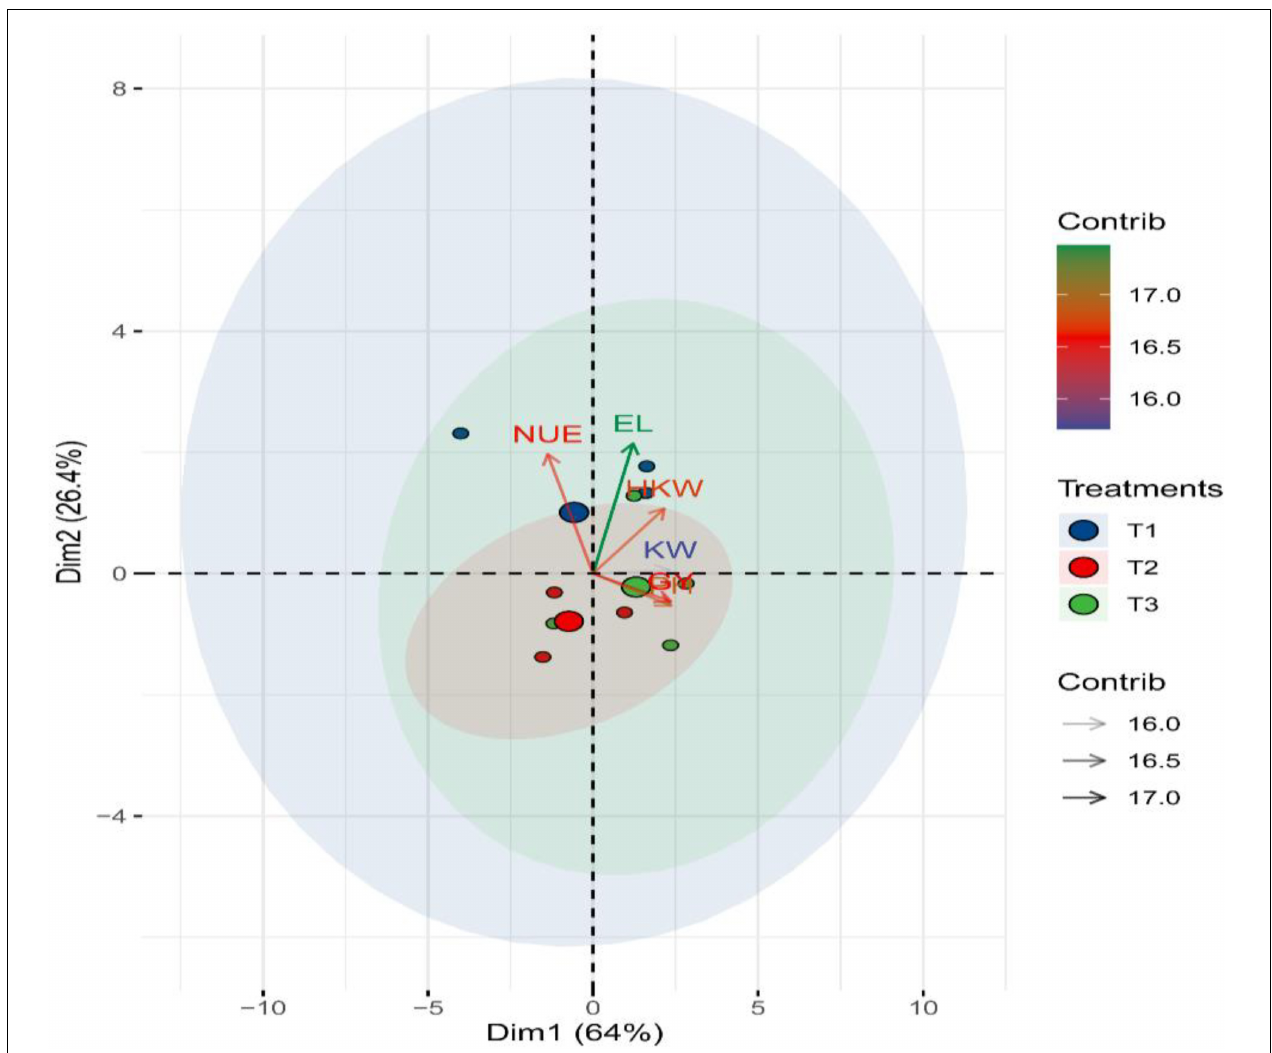
FIGURE 4 | PCA analysis shows the correlations between agronomic traits and NUE traits according to the N fertilization levels and application time over 2 years. Diagrams are defined by the first two axes of the PCA of the different variables ( n = 3); Axis1 (64% of variance explained) and Axis2 (26.4% of variance explained), where T 1 (50% of N at each of sowing and 1st irrigation), T 2 (50% of N at each of sowing and 2nd irrigation) and T 3 (50% of N at each of 1st and 2nd